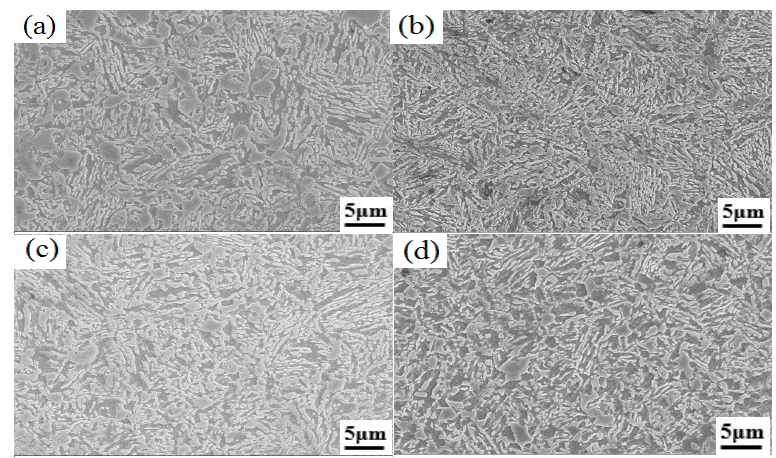
Figure 3. SEM images of TAM steels with various vanadium contents. ( a ) 0.052%V, ( b ) 0.098%V, ( c ) 0.21%V, ( d ) 0%V.